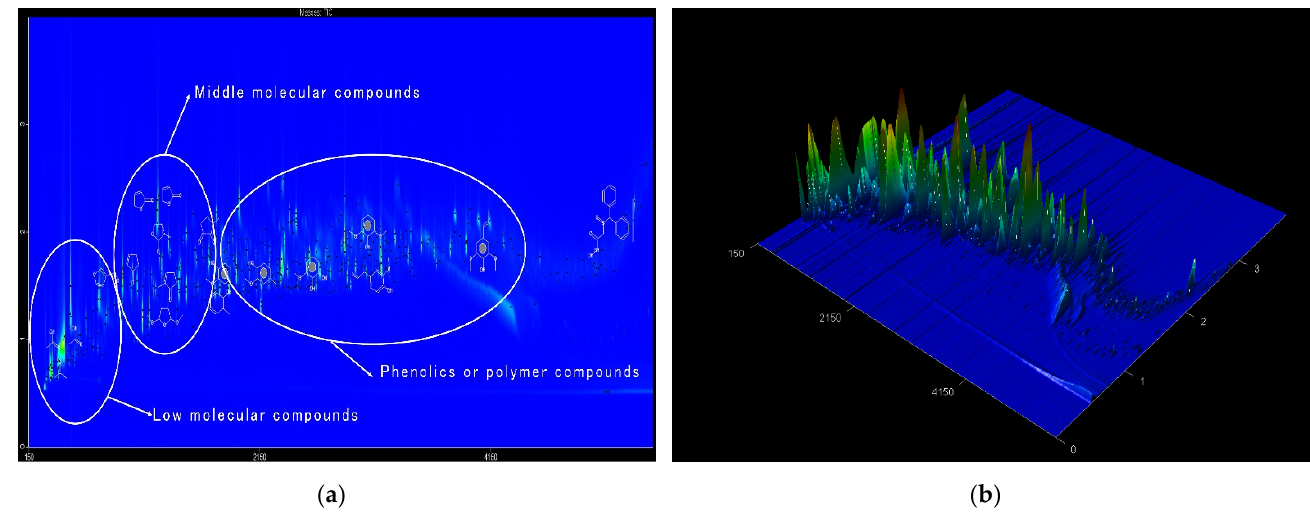
Figure 2 . GC × GC TOF/MS chromatogram of FPBO: ( a ) 2-D; ( b ) 3-D. x = retention time, y = TOF axis, z = peak intensity.